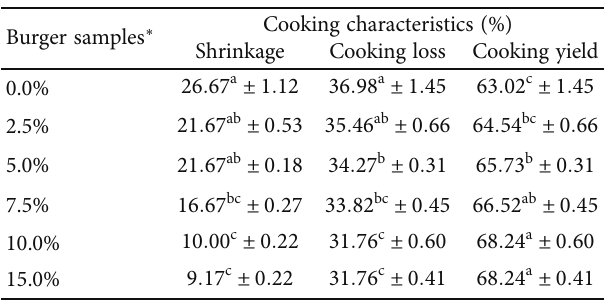
∗ Camel meat burgers partially substituted with UBDF pulp as a fi ber source. a,b,c No signi fi cant di ff erence ( p > 0 : 05 ) between any two means within the same column with the same superscripted letters. Table 5: Cooking characteristics of roasted camel meat burger as a ff ected by replacing fat with di ff erent levels of UBDF pulp.